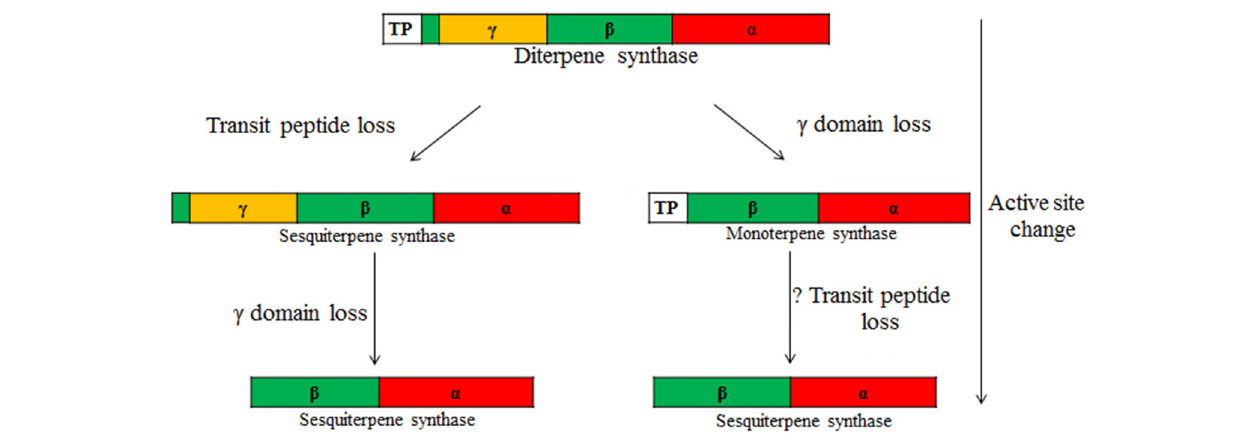
FIGURE 3 | Hypothesis of the evolution of multi-substrate enzymes according to two potential routes. Ancient terpenoid synthases underlying the diversity of terpene synthases in plants are tri-domain, α -, β ,- and γ -domain proteins with two active sites, one in the α -domain (class I activity) and the other in the β -domain (class II activity) ( Christianson, 2006, 2008; Köksal et al., 2011a,b). The γ -domain without an active site is inserted between the first and second helices of the β -domain ( Köksal et al., 2011a,b). These ancient proteins also carry a transit peptide (TP) at the N terminus targeting these proteins to chloroplasts. Through evolution, these complex enzymes have undergone considerable simplification, resulting in changes in catalysis, enzyme subcellular localization, and product and substrate specificities. Class II activity seems to have been lost first (not shown in the figure) and is missing in all confirmed multi-substrate enzymes. A tri-domain terpene synthase functionally active in the cytosol is formed through the loss of the transit peptide from a diterpene synthase. This can be eventually followed by γ -domain loss, resulting in formation of a bi-domain cytosol-active synthase (left). While the transit peptide is maintained, γ -domain loss can first lead to formation of a bi-domain diterpene synthase (e.g., ent -kaurene synthase like synthase in Triticum aestivum , Figure 2 , Table 1 ) and ultimately to a monoterpene synthase. Loss of the transit peptide can further lead to a cytosol-active enzyme (e.g., β -ocimene synthase, AtTPS02, and ( E,E )- α -farnesene synthase, AtTPS03, from Arabidopsis thaliana that differ in the subcellular localization due to presence or lack of the transit peptide; Figure 2 , Table 1 ). Changes in substrate specificity are typically also associated with changes in active center size ( Köksal et al., 2011b), and thus, the capacity for the use of multiple substrates will critically depend on whether the active center cavity can accommodate substrates of varying